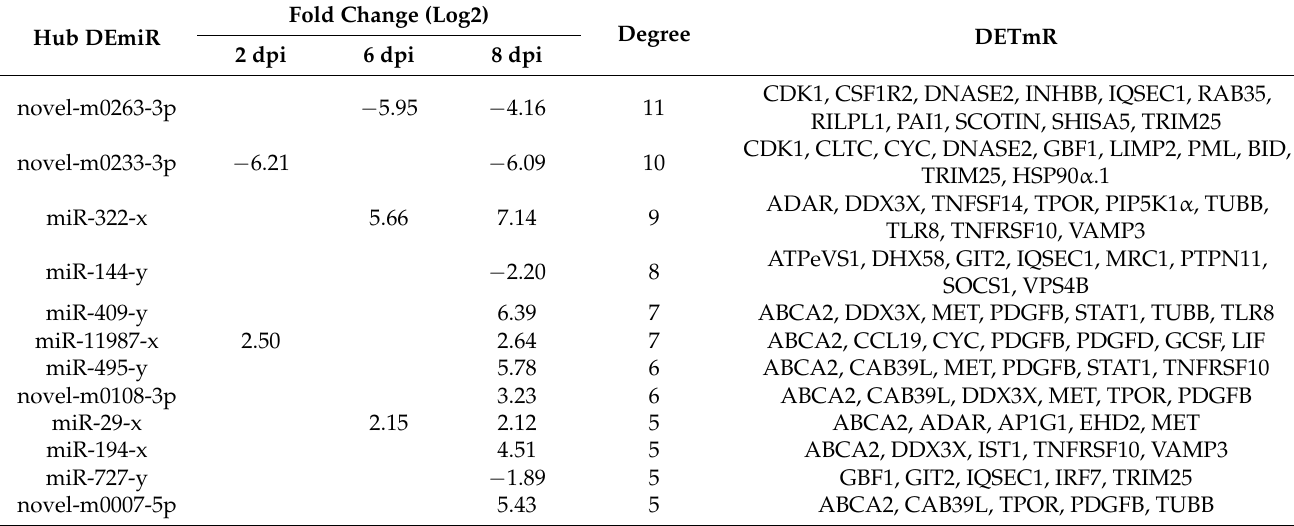
Table 3. The 12 DEmiRs that formed the interactive network. For each DEmiR, the fold difference in expression between virus-infected and uninfected fish at 2, 6, and 8 dpi are indicated. Degree represents the number of differentially expressed target mRNAs (DETmRs) interacting with the DEmiRs in the